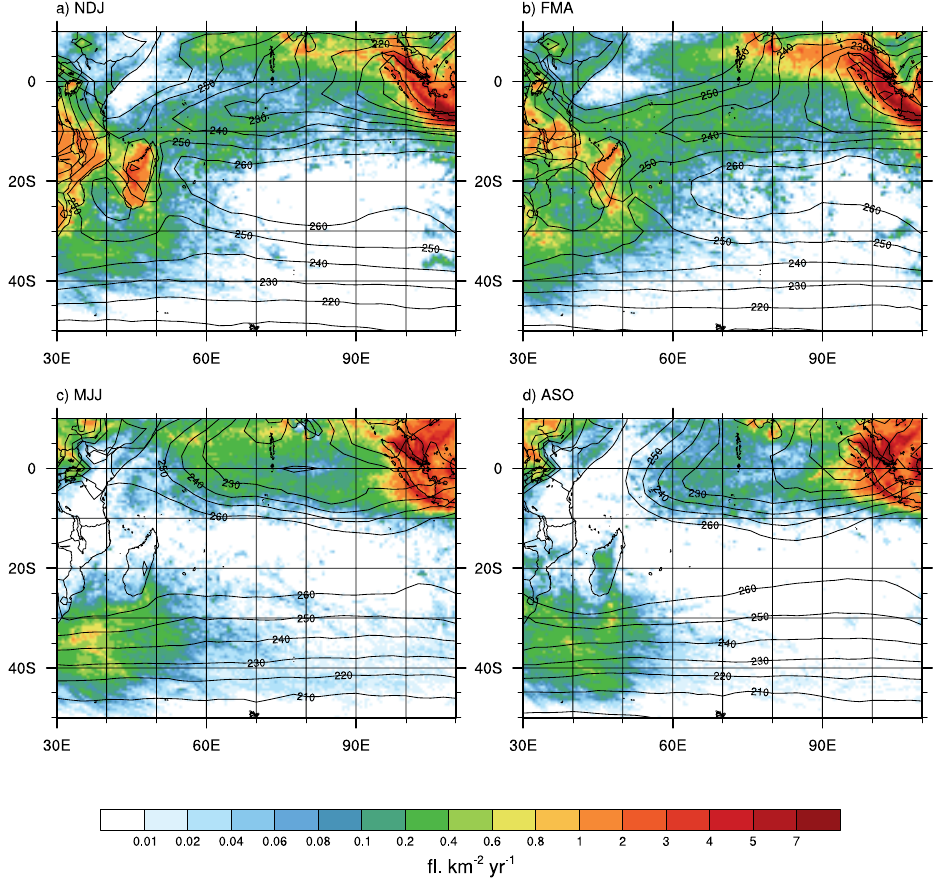
Fig. 4. The trimestrial distribution of lightning activity (flkm − 2 yr − 1 ) for the period 2005–2011: (a) November, December and January, (b) February, March and April, (c) May, June and July and (d) August, September and October. Contours correspond to OLR values (Wm − 2